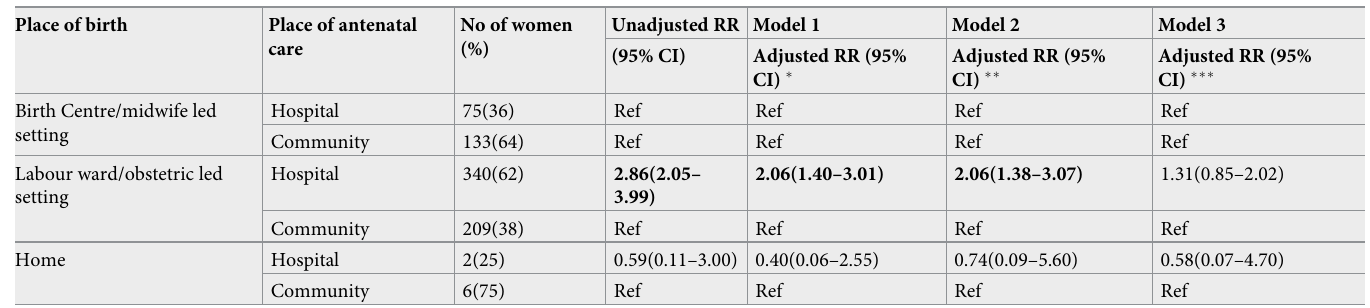
� Model 1: Adjustment for demographics ethnicity, age, parity, IMD score, social risk and medical risk factors at booking and onset of labour. �� Model 2: Model 1 + adjustment for model of care. ��� Model 3: Model 2 + adjustment for service provider attended.